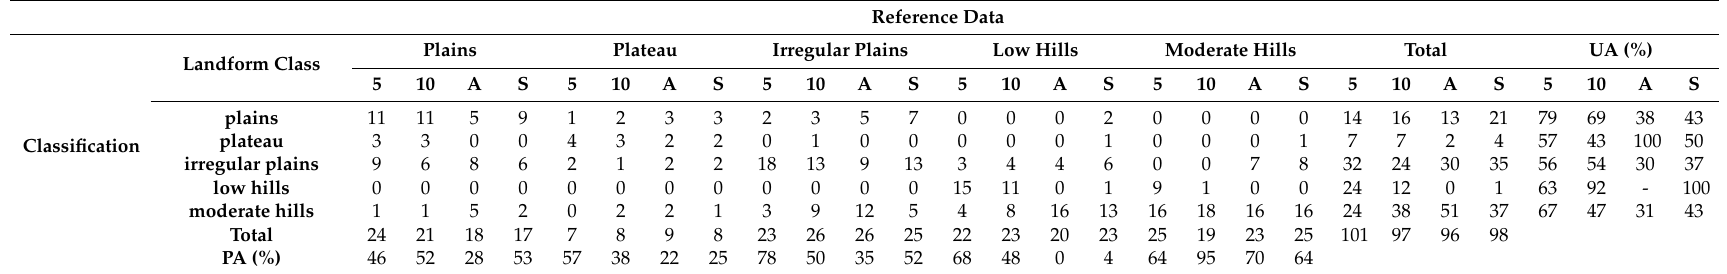
Table A1. Error matrix based on classified landform units for Dikau’s approach for the four different DEMs (5 = 5 m, 10 = 10 m, A = Aster 30 m, S = SRTM 30 m) with producer’s accuracy (PA) and user’s accuracy (UA).